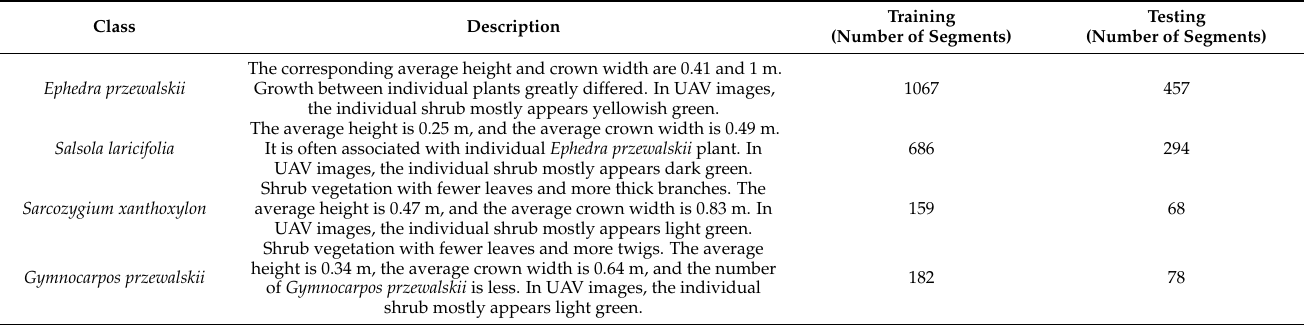
Table 1. The shrub species classification category adopted and the number of training and testing samples. Class Description Training (Number of Segments) Testing (Number of Segments) Ephedra przewalskii 1067 457 686